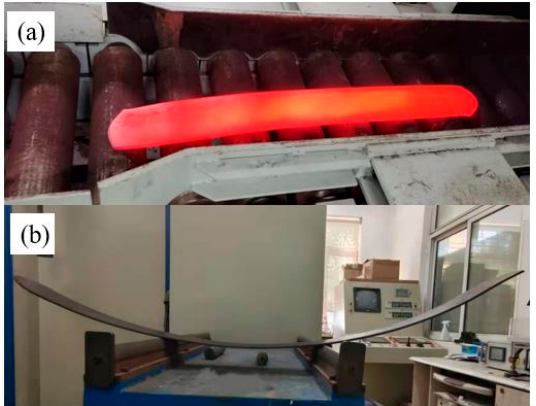
Figure 15. Hot rolling experiment diagram of the clad plate. ( a ) warpage diagram of the clad plate during hot rolling, ( b ) warpage diagram of the clad plate after hot rolling.